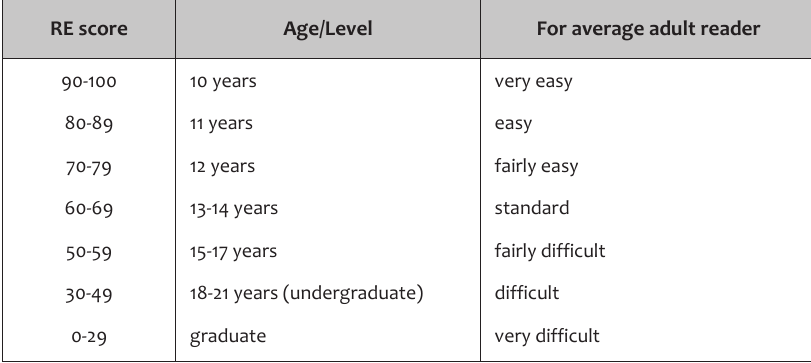
Table 1: Reading ease categories (based on the RE formula) RE